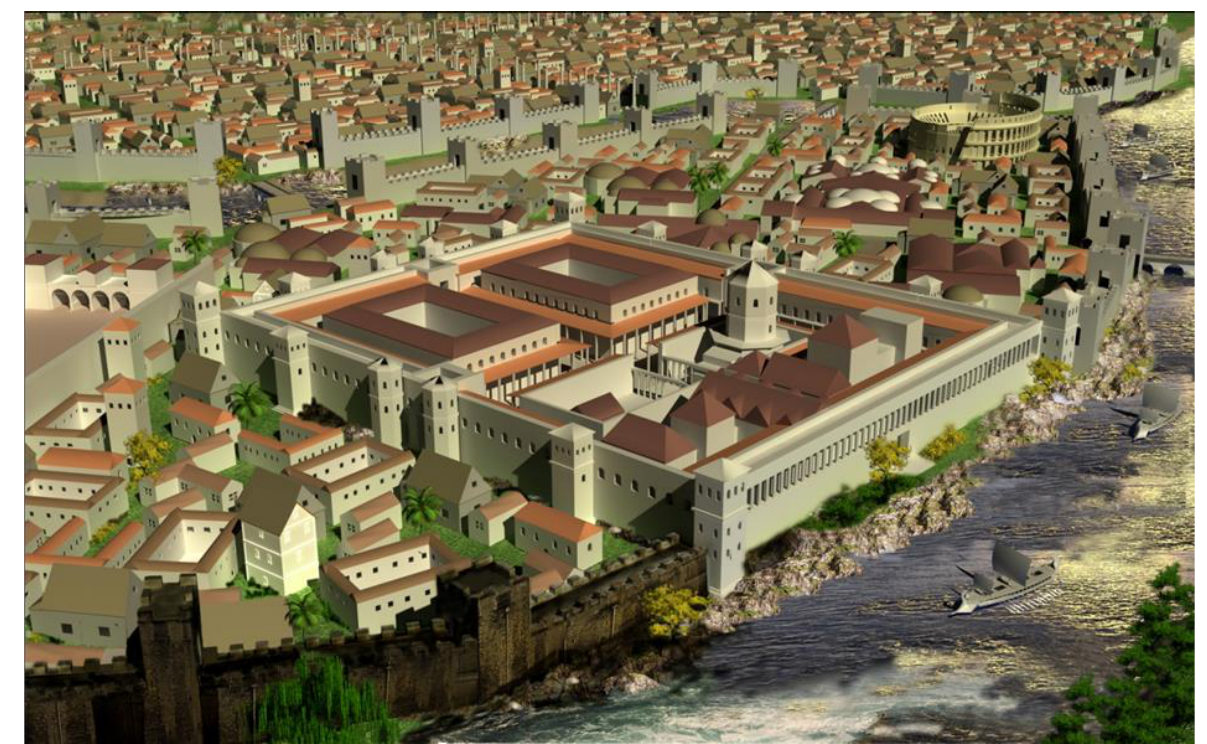
Figure 7. Ancient Antioch’s Imperial Palace on the island in the Orontes River .